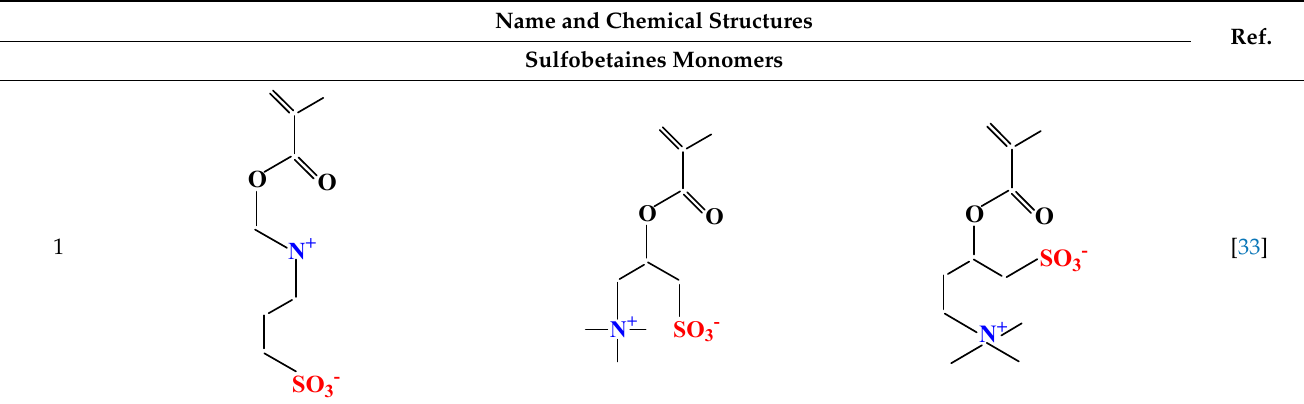
Table 1. Structures of betainic monomers and polybetaines with antifouling properties. Name and Chemical Structures